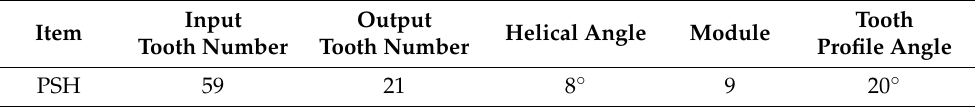
Table 3. Design parameters of the helical gear set.